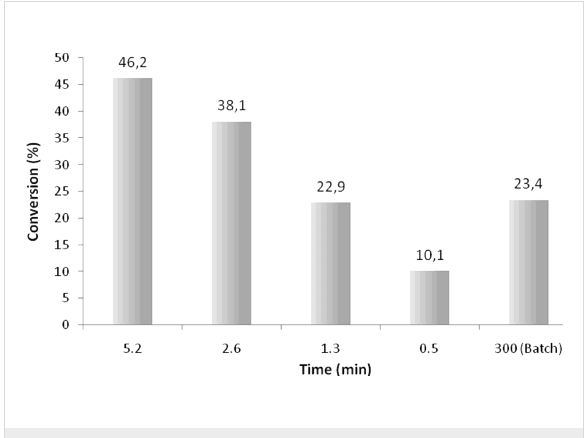
Figure 2: Graph illustrating the effect of flow rate (hence residence time) on the conversion of 1-methylcyclohexene ( 6 ) to 1-methylcyclo- hexene oxide ( 7 ) at room temperature (27 °C); employing 2.0 equiv of H 2 O 2 ( 2